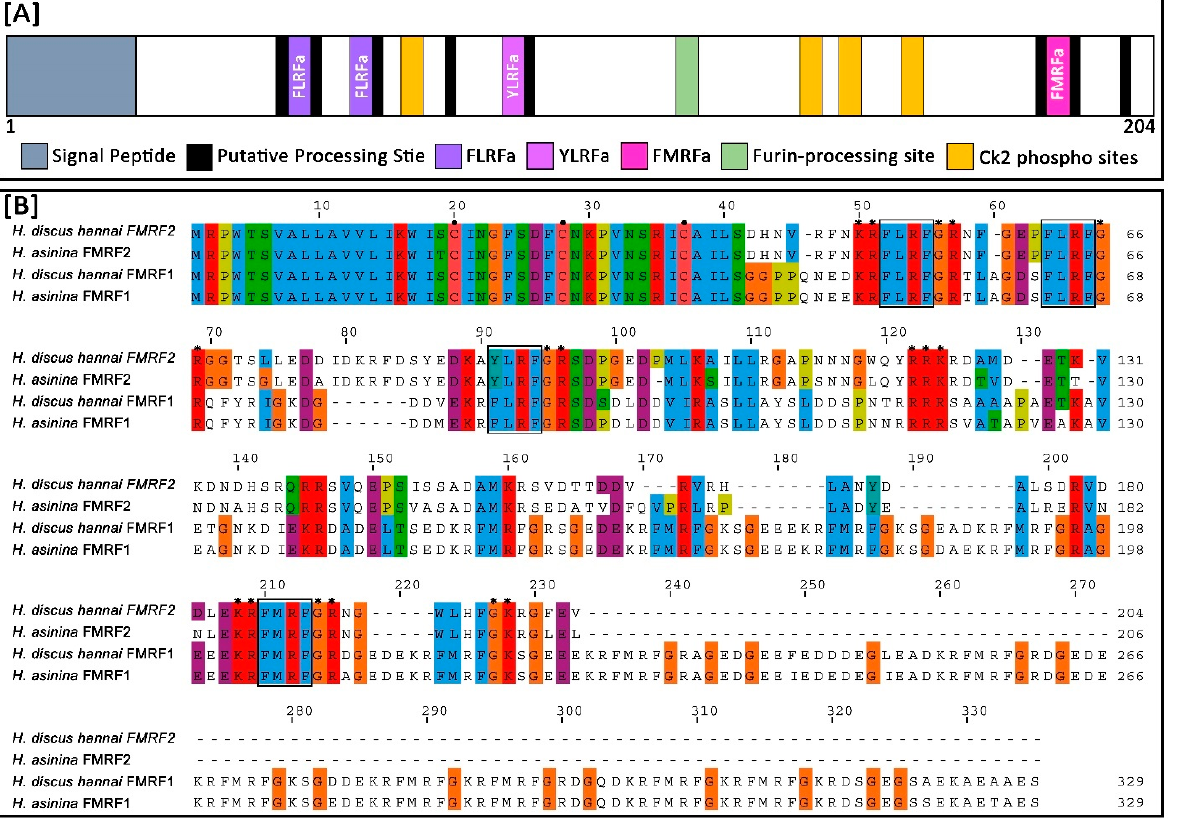
Figure 2. Structure of Hdh-FMRF2 amino acid sequence and multiple sequence alignment of the predicted amino acid sequences of FMRFamide in different abalone species. ( A ) The Hdh-FMRF2 peptide contains two FLRF motifs (violet), one YLRF motif (purple), one FMRF motif (pink), a conserved tetrabasic furin-processing site (mint green), four Ck2 phosphorylation sites (orange), and several putative processing sites flanked by a pair of amino acids (black). ( B ) Multiple sequence alignment of the predicted amino acid sequences of different FMRFamide peptides from H. discus hannai and H. asinine (details of sequences are presented in Supplementary Table S3). The dashes indicate sequence gaps. Three conserved cysteine residues in the aligned sequences are marked with dots. Predicted FaRP domains are marked in black lined box. Processing sites are marked with stars. Table 1. Amino acid percent identity and percent similarity among FMRF1 and FMRF2 amino acid sequences of H. discus hannai and H. asinina . Table 2. Comparison of peptide predicted between Hdh-FMRF1 and Hdh-FRMF2 precursors of H. discus hannai